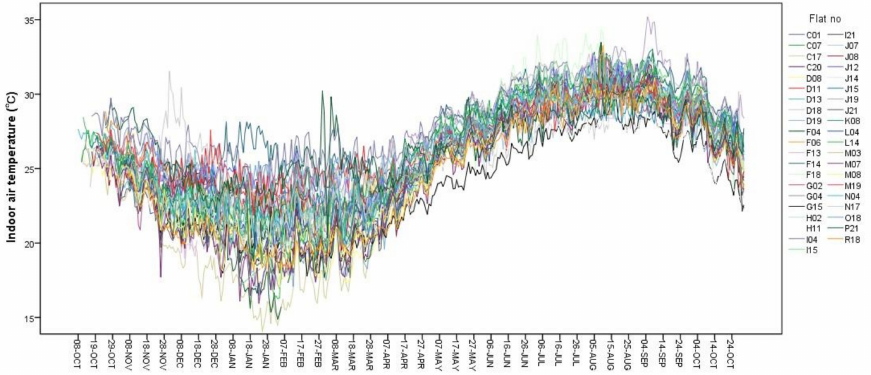
Figure 5. Indoor air temperature according to the flats.